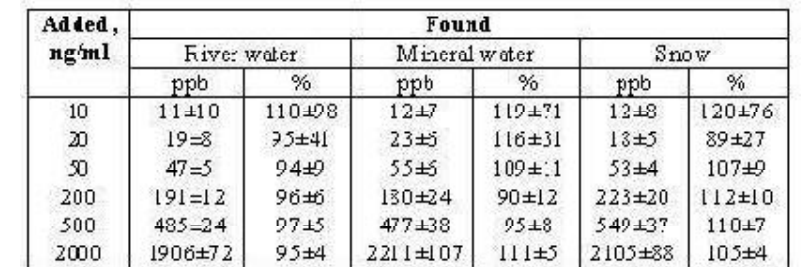
Recovery Test in Natural Water. PCP Was Spiked into River Water, Mineral Water, and Snow Samples (n = 3, p =